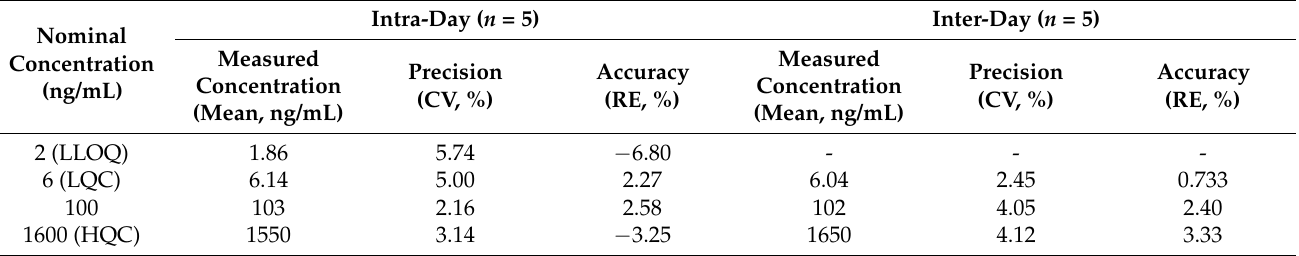
Table 1. Precision and accuracy of the analytical method for the determination of DA-6886 in rat